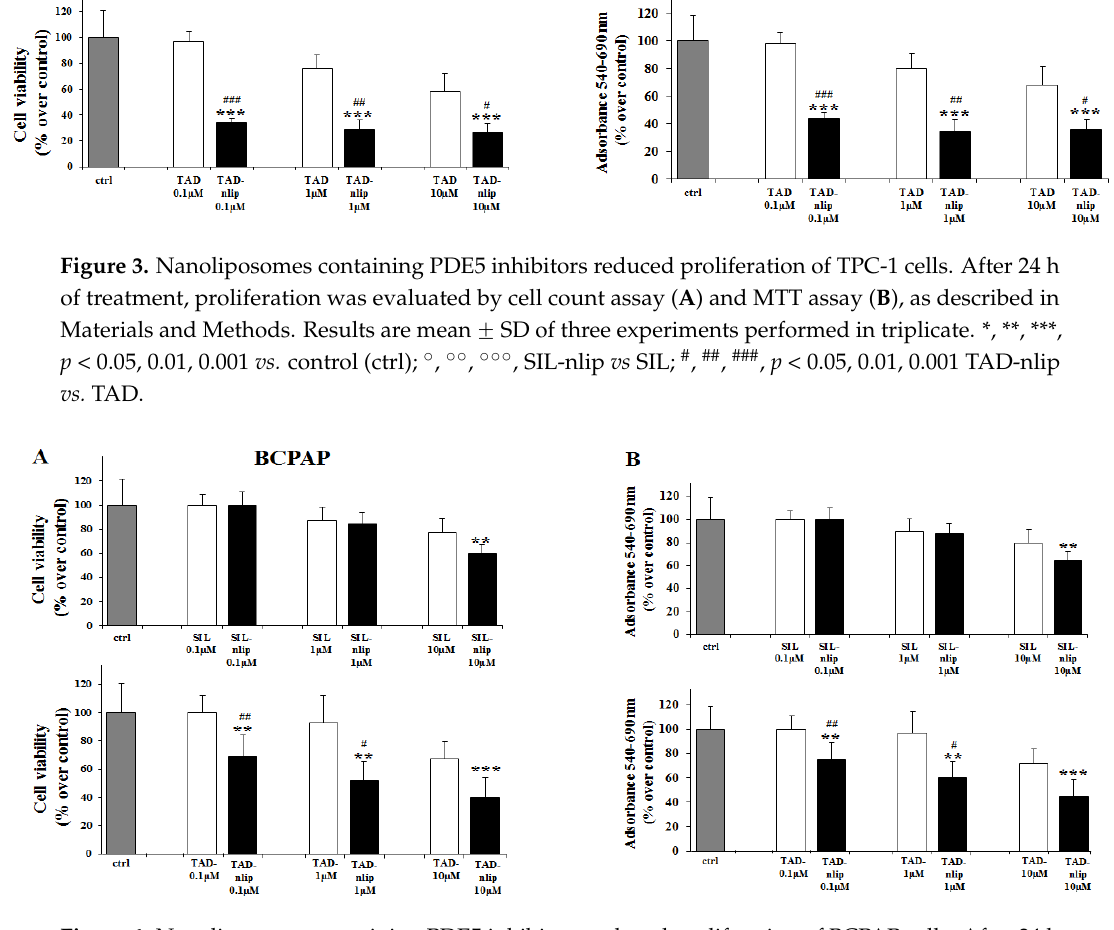
Figure 4. Nanoliposomes containing PDE5 inhibitors reduced proliferation of BCPAP cells. After 24 h of treatment, proliferation was evaluated by cell count assay ( A ) and MTT assay ( B ), as described in Materials and Methods. Results are mean ± SD of three experiments performed in triplicate. *, **, ***, p < 0.05, 0.01, 0.001 vs. control (ctrl); # , ## , p < 0.05, 0.01 TAD-nlip vs. TAD.